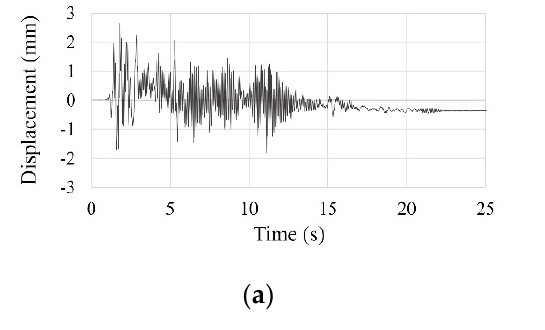
Figure 12. Time history curve of the small-scale model under sinusoidal forced vibration equal to scaled El Centro earthquake.